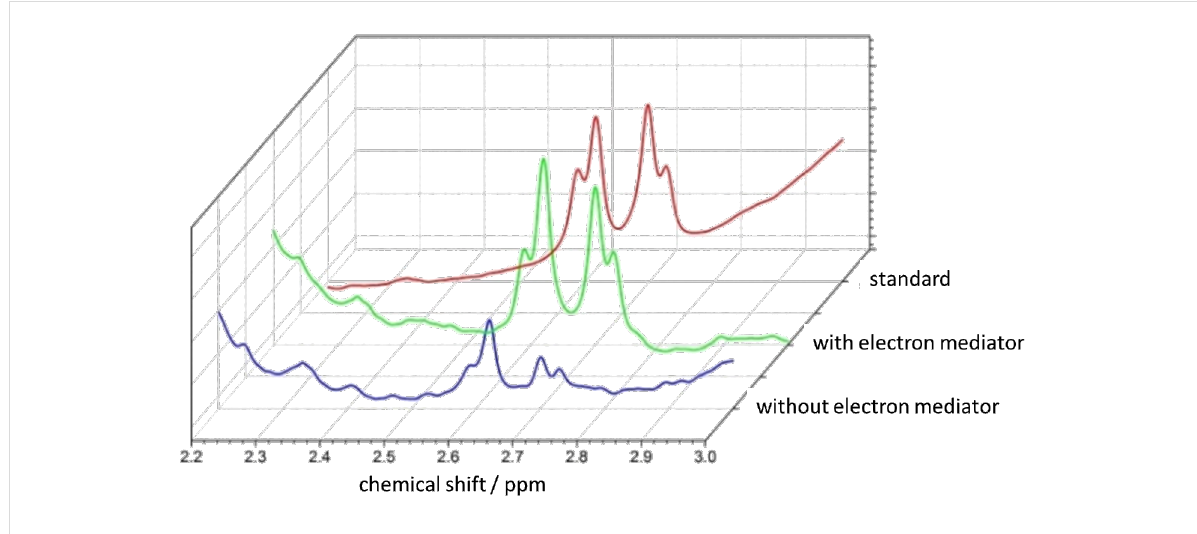
Figure 5: 1 H NMR spectrum of a standard 1,4-NADH (red line), and of 1,4-NADH formed from NAD + upon photocatalysis in the absence (blue) and the presence (green) of the Rh-complex as a mediator and [CrF 5 (H 2 O)] 2 − @TiO 2 as a photocatalyst.